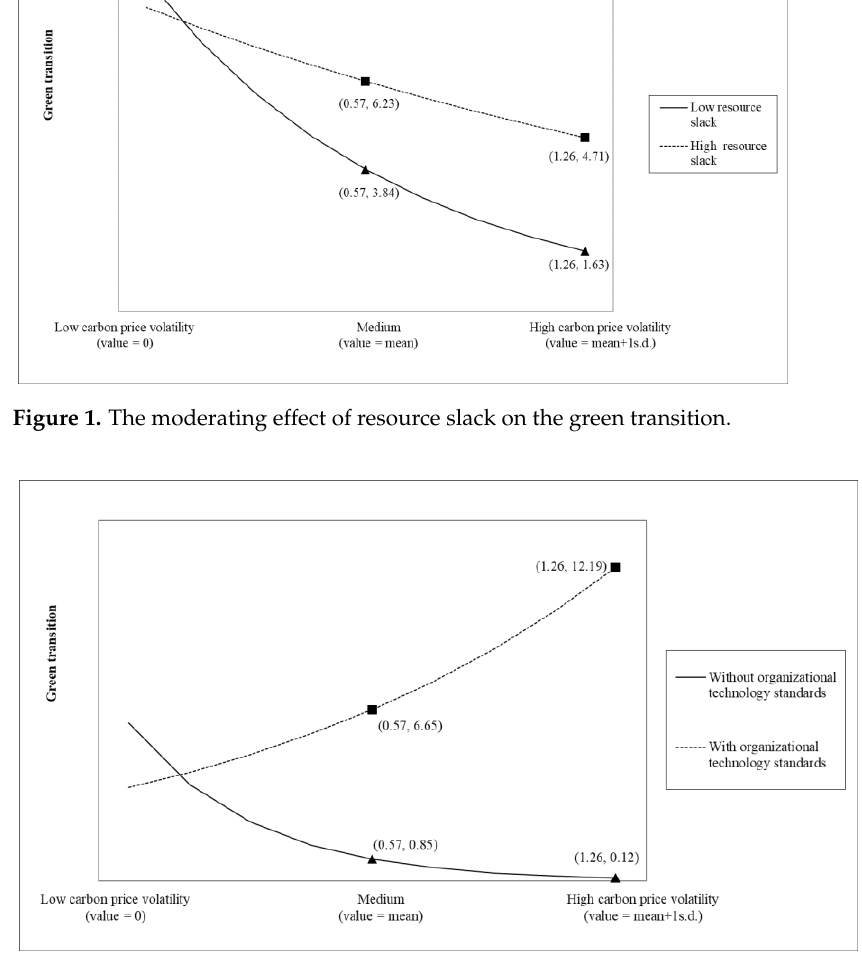
Figure 2. The moderating effect of organizational technical standards on the green